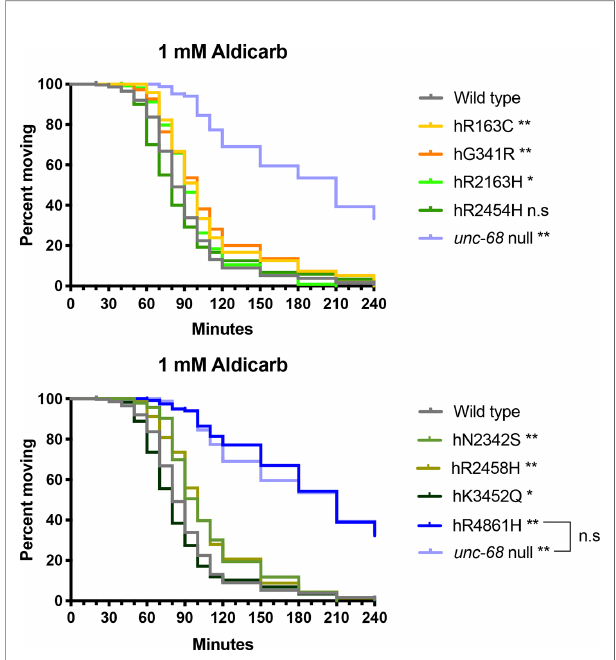
FIGURE 5 | Ryanodine receptor (RyR) variants alter time to paralysis in 1 mM aldicarb. Kaplan-Meier survival curves representing the percentage of individuals still moving with time in 1 mM aldicarb. Data for the RyR variant strains, labelled by the human variant they correspond to, along with the N2 wild type and the CB540 unc-68(e540 ) null mutant are distributed across two graphs for clarity. Comparison to the wild type, and of the hR4861H variant strain to the unc-68 null mutant (square bracket), to assess if curves were signi fi cantly different, employed the Gehan-Breslow-Wilcoxon test; * P < 0.05, * P < 0.005, n.s, not signi fi